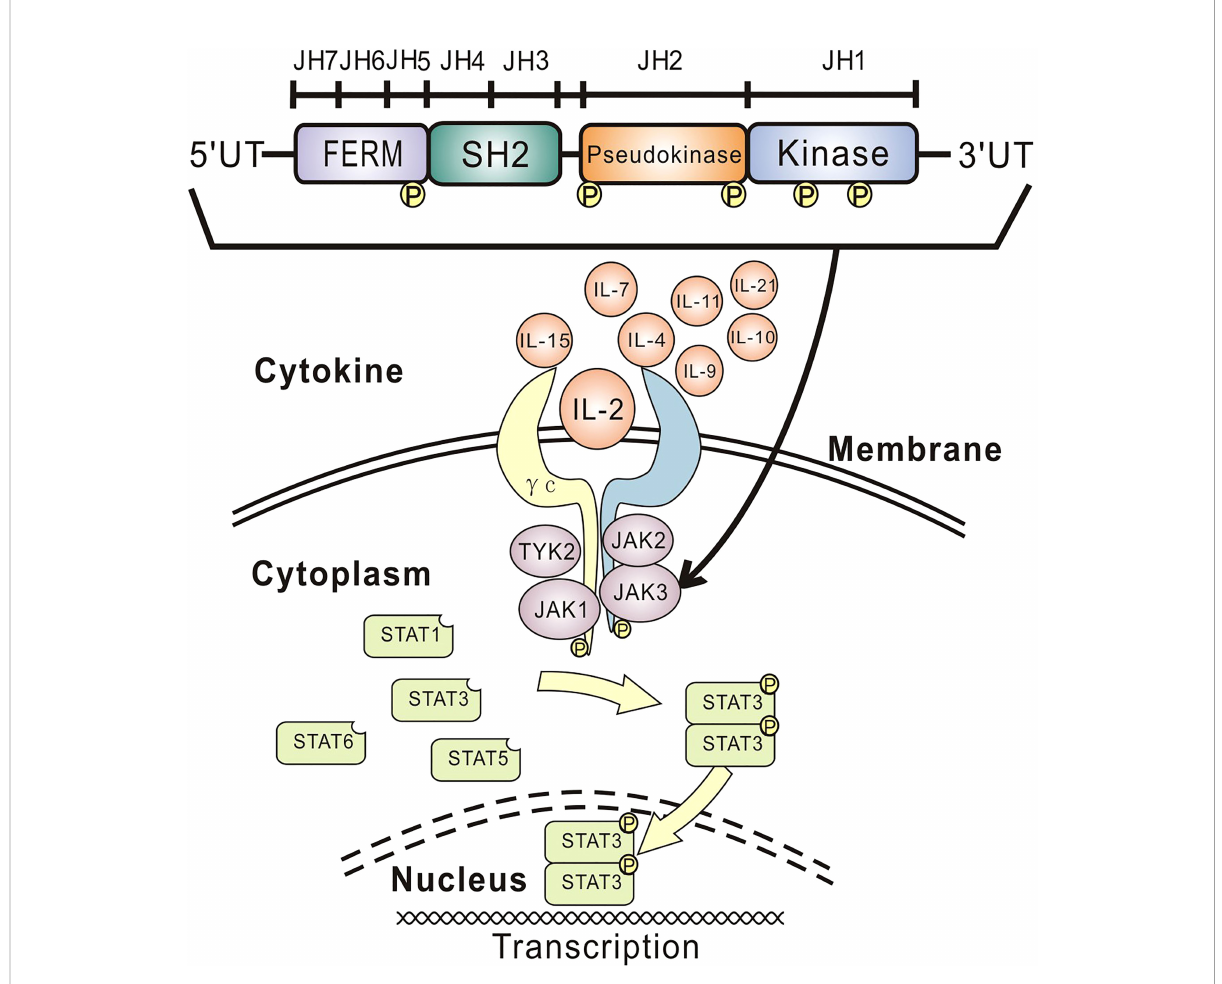
FIGURE 2 Overview of cytokine signaling and JAK3 structure. Intracellular activation signal through cytokine- g c- JAK3 binding induces JAK3 to phosphorylate STAT proteins, which therefore dimerize and translocate to the nucleus to initiate the transcription program. The JAK family includes four homologs (i.e., JAK1, JAK2, JAK3 , and TYK2), each containing seven conserved JH domains. The JH1 (kinase) domain regulates kinase activity, and the JH2 (pseudokinase) domain is essential for normal JAK3 functions, including catalytic activity and autophosphorylation. The SH2-like JH3, JH4, and JH5 domains are considered imperative for the in vivo assembly of the JAKs. The JH5, JH6, and JH7 domains (namely, FERM) are required for binding to g c for signal transduction and regulating catalytic activity. JAK, Janus kinase; g c, gamma chain; STAT, signal transducer and activator of transcription; JH, Janus homology; IL, interleukin; FERM, four-point-one, ezrin, radixin, moesin; SH2, Src homology-2; TYK2, tyrosine kinase